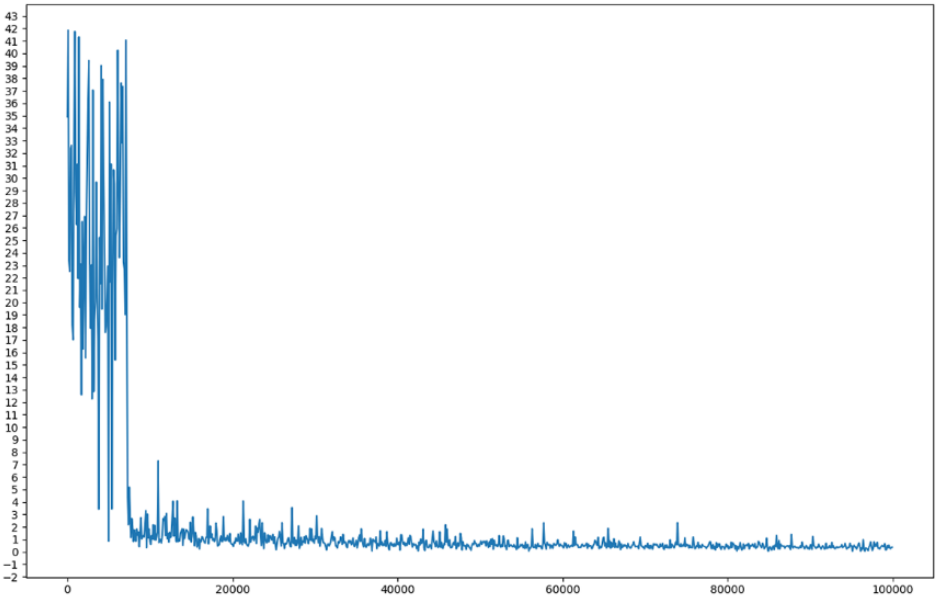
Figure 9. The loss value of FCN during training. It shows the trend of loss values during training. From the figure, we can see that in the early period of the iteration (about before 5000 times), the loss value violently oscillated and then dropped sharply. In the medium term (around 5000 – 50,000), the loss value decreased slightly and tended to be stable. In order to ensure that the network has stabilized, we chose 60,000 as the number of iterations.